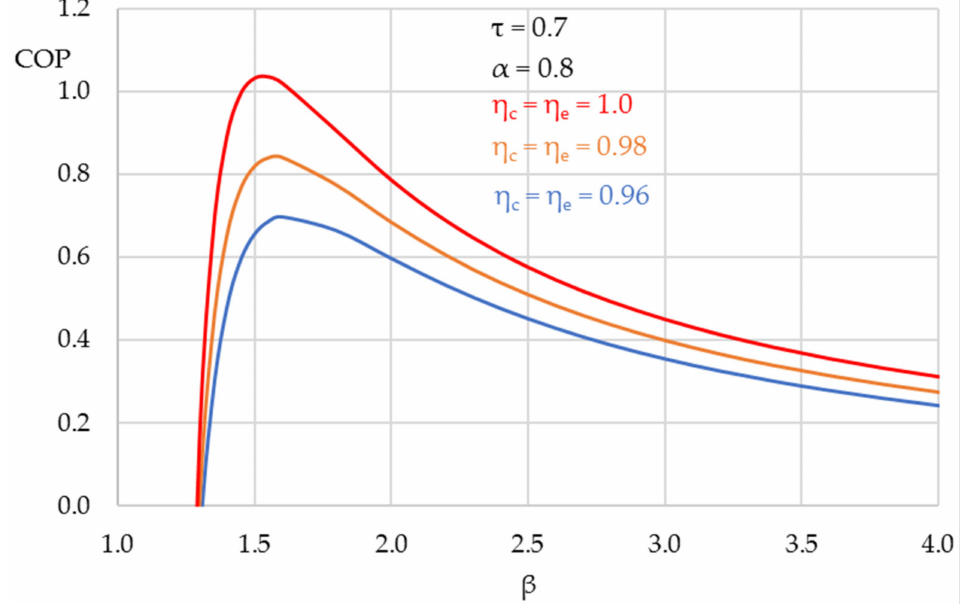
Figure 5. Correlation of the COP with the ratio of the magnetic fields β for various values of η e = η c , by fixing τ = 0.7 and α = 0.8.